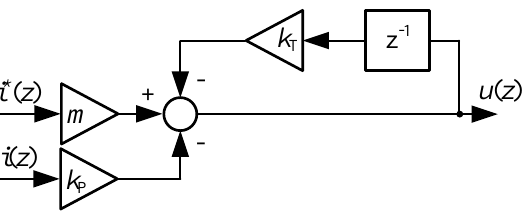
Figure 5. Block scheme of the state feedback current controller.